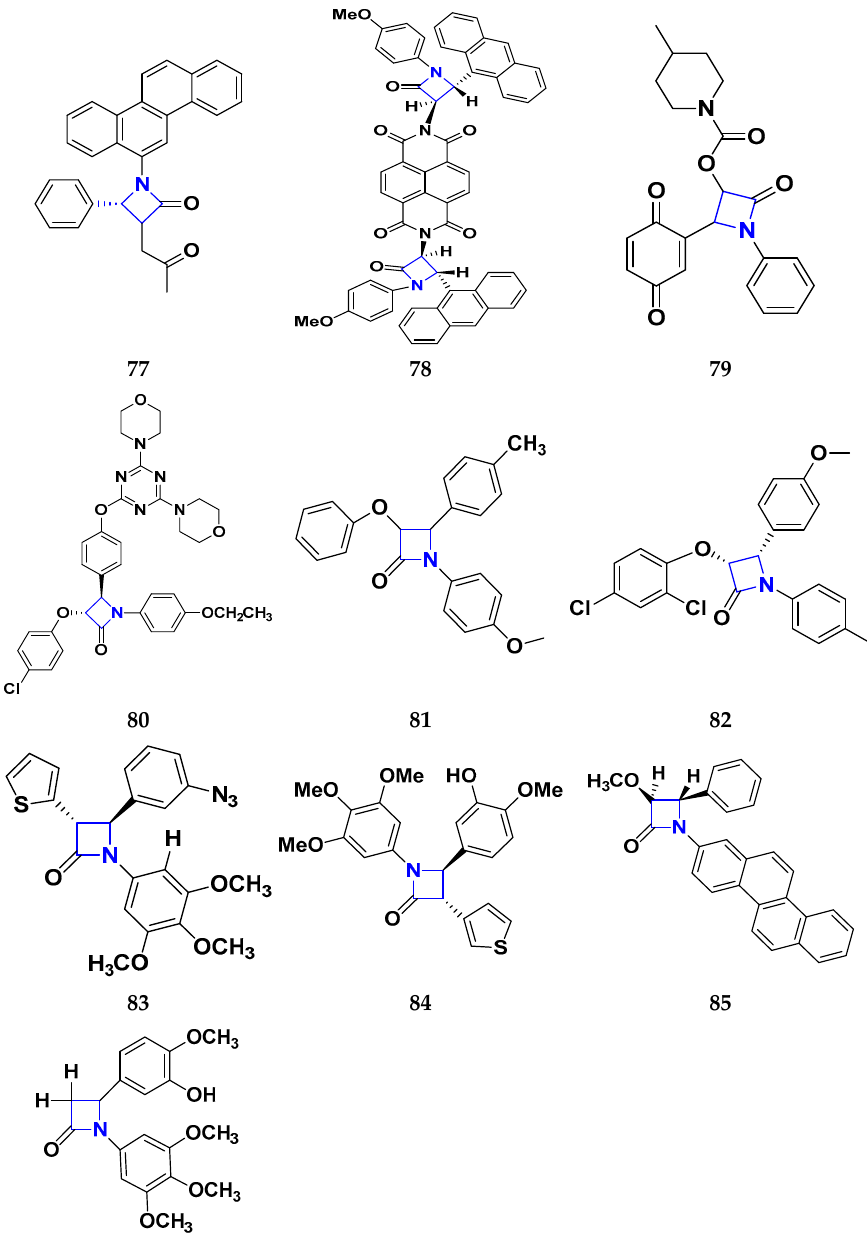
Figure 10. β -lactam derivatives ( 77 – 86 ) as anticancer agents.